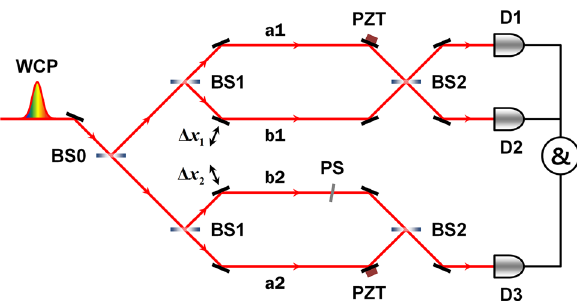
Figure 9. Experimental setup to observe the two-photon interference of spatially separated weak coherent pulses (WCPs). Two balanced Mach–Zehnder interferometers are positioned after a beam splitter (BS0). BS, 50:50 beam splitter; PS, phase shifter; D, single-photon detector. Phase randomization is synchronously performed by the two PZTs, and (cid:31) x 1 and (cid:31) x 2 simultaneously introduce path-length differences between the two interferometer arms in the two spatially separated